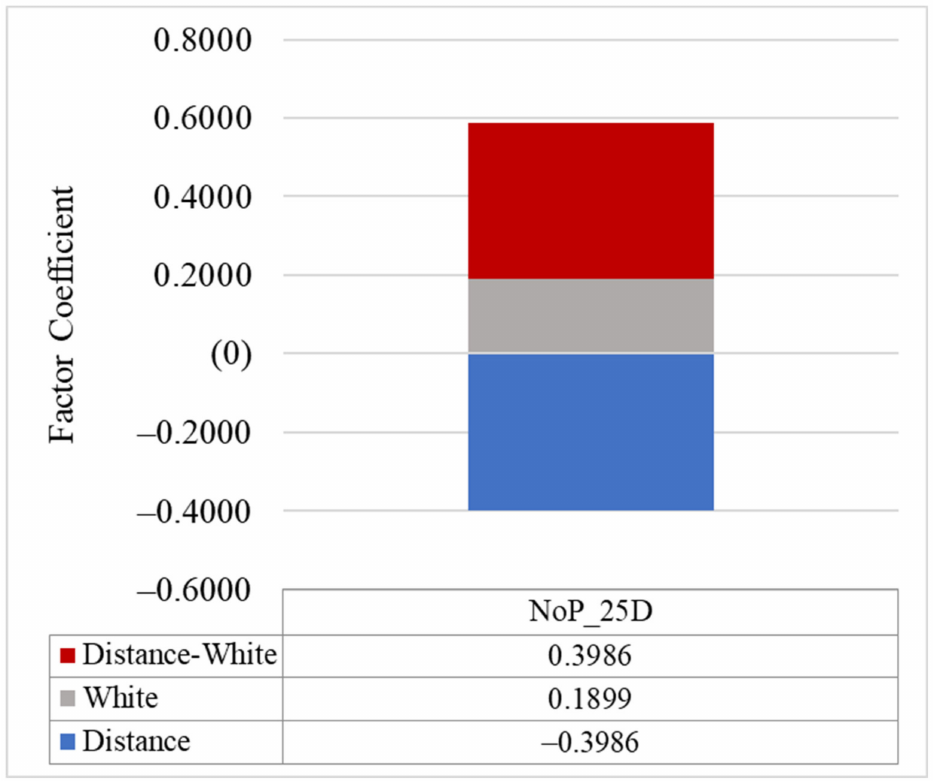
Figure 4. Coefficients of the significant factors for statistically reliable models associated to NoP. The associated error is equal to 0.05%.